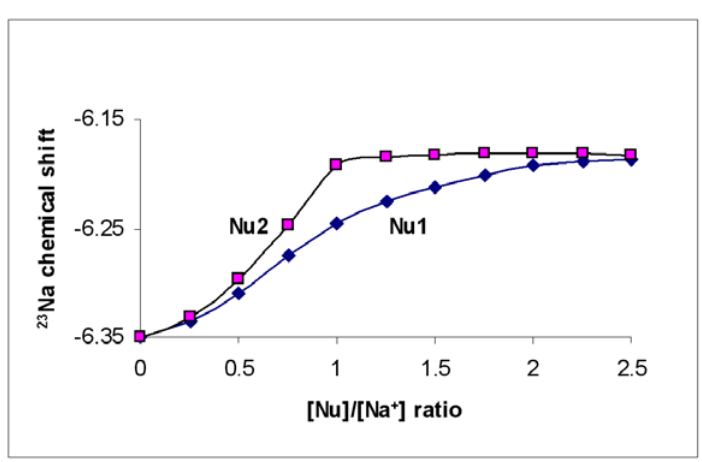
Fig. 4 Variation in the 23 Na chemical shifts as function of [Nu]/[Na + ] ratio for Nu1 or Nu2.